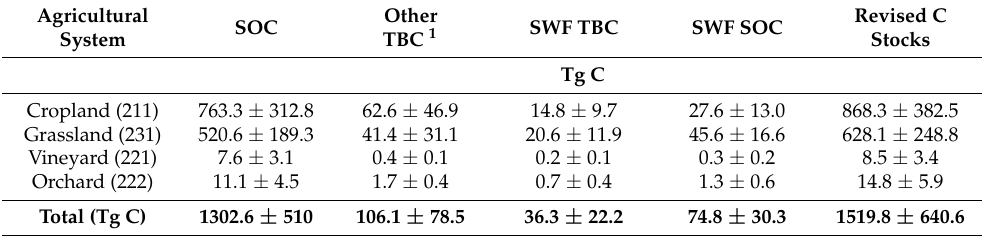
Table 3. Revised carbon stocks ( ± SD; in Tg C) in Germany after the inclusion of the total biomass carbon stock (TBC, in Tg C) of herbaceous vegetation (including crops), perennial crops, and SWFs. SOC—soil organic carbon, SWF—small woody landscape feature. Numbers refer to CORINE codes.